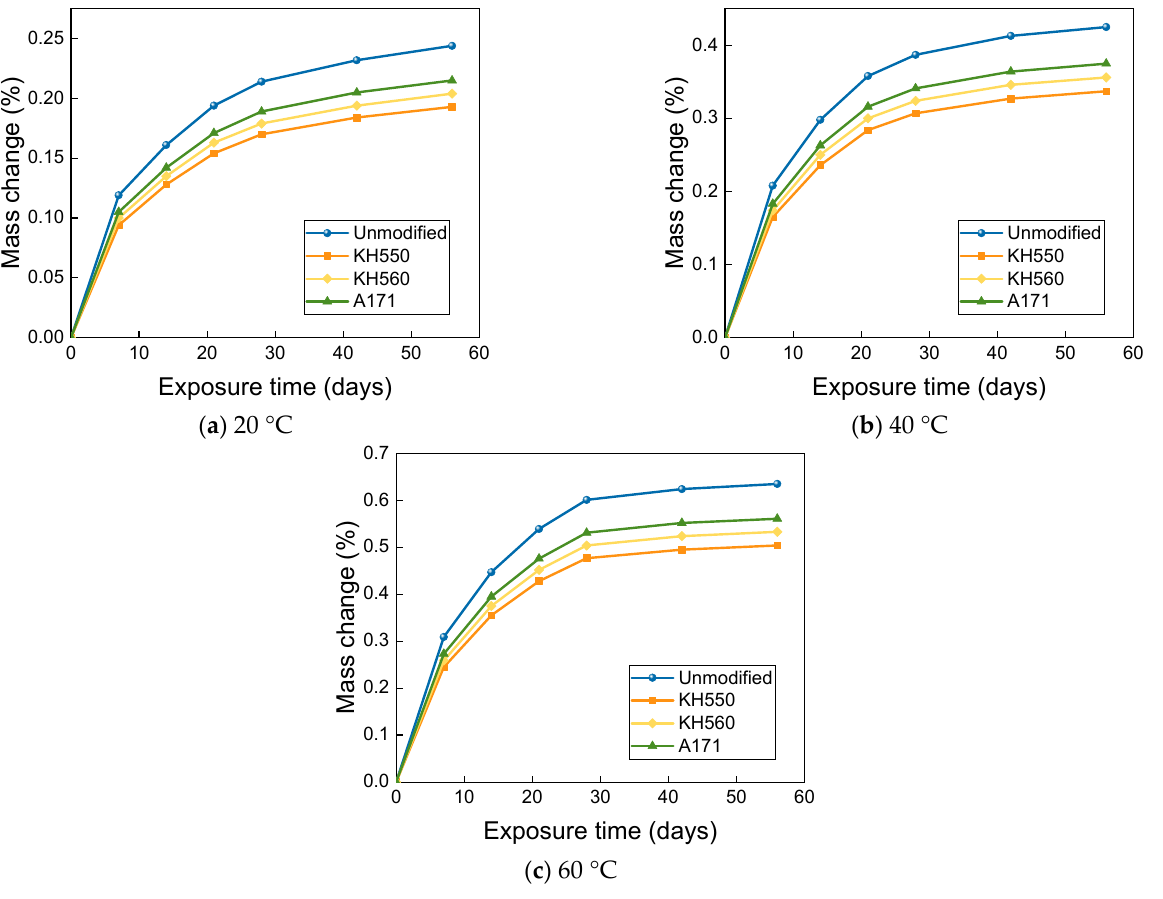
Figure 12. Mass change in a water environment. The mass changes of BFRPs under different temperatures in 3.5% NaCl seawater environments are shown in Figure 13. The mass growth was rapid at the early stage of immersion, and the mass growth rate leveled off in the middle of immersion but showed an overall increasing trend. After soaking for 56 days in 20 °C seawater environments, the mass of unmodified and KH550, KH560, and A171 silane-coupling-agent-modified BFRPs increased by 0.231%, 0.182%, 0.193%, and 0.204%; after soaking for 56 days in 40 °C seawater environments, the mass of unmodified and KH550, KH560, and A171 silane-coupling-agent-modified BFRPs increased by 0.403%, 0.320%, 0.338%, and 0.356%. The mass of BFRPs modified with KH550, KH560, and A171 silane coupling agents increased by 0.603%, 0.478%, 0.505%, and 0.532% after 56 days of immersion in seawater environments at 60 °C. As shown in Figure 14, the mass change of BFRPs under immersion in 10% NaCl high-concentration seawater environments at different temperatures followed a two-stage pattern. The mass of the BFRPs grew rapidly in the initial stage of immersion, and the mass of BFRPs still grew in the subsequent stages, but the growth rate kept decreasing. After 56 days of immersion in 20 °C seawater environments, the mass of unmodified and KH550, KH560, and A171 silane-coupling-agent-modified BFRPs increased by 0.216%, 0.171%, 0.181%, and 0.189%; after 56 days of immersion in a seawater environment at 40 °C, the masses of the unmodified and KH550, KH560, and A171 silane-coupling-agent-modified composites increased by 0.376%, 0.298%, 0.315%, and 0.332%; after 56 days of immersion in